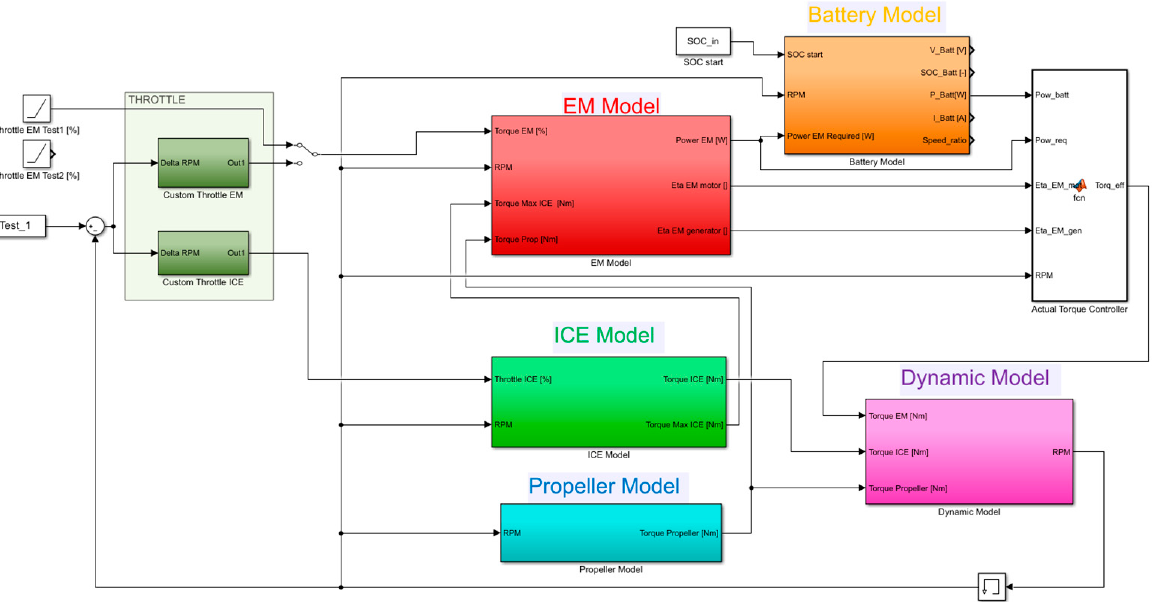
Figure 6. Block scheme of the MATLAB Simulink overall model.